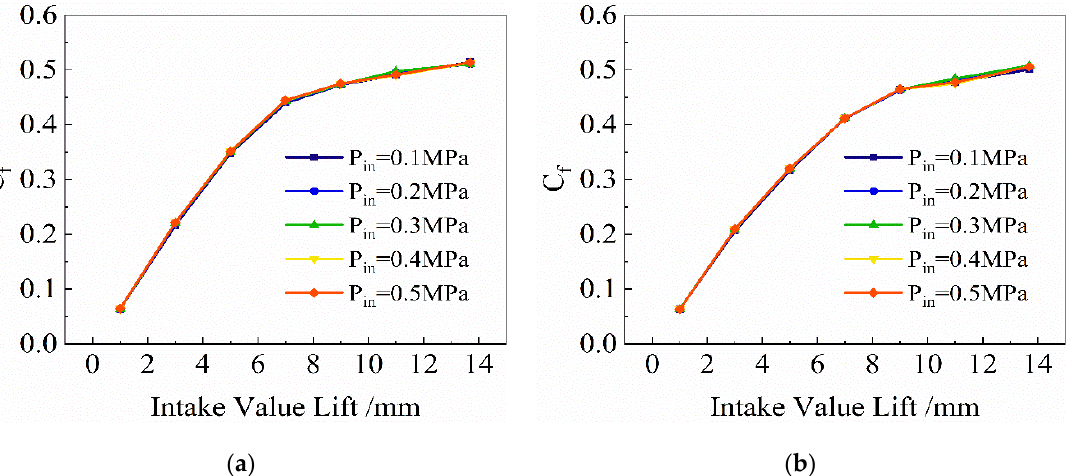
Figure 2. ( a ) Different intake pressure under 42 mm throat; ( b ) different intake pressure under 43 mm